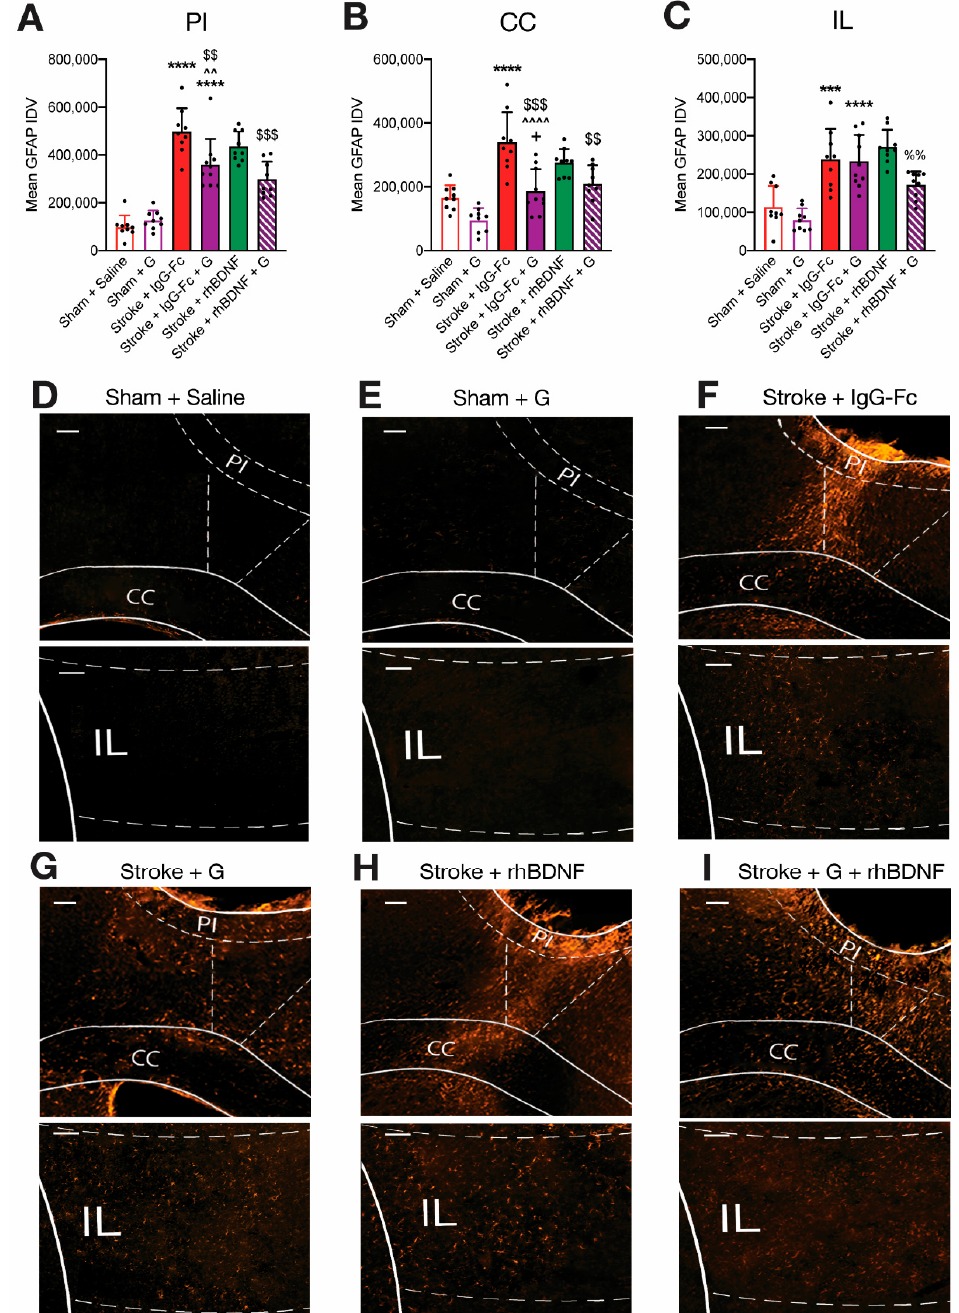
Figure 7. Effects of compound G treatment, with or without rhBDNF, on stroke-induced reactive astrogliosis. PFC strokes induced a significant upregulation in the mean integrated density value (IDV) of GFAP+ve expression in the peri-infarct (PI, ( A )), corpus callosum (CC, ( B )) and infralimbic (IL, ( C )) regions of vehicle-treated animals (sham + saline, n = 9; stroke + IgG-Fc, n = 9). Compound G treatment alone had no effect in sham animals ( n = 9) but significantly dampened stroke-induced elevations in GFAP+ve expression in the PI and CC regions of stroke animals ( n = 9). Moreover, compound G + rhBDNF treatment ( n = 9) further caused a reduction in GFAP+ve expression within IL regions ( D – I ). Two-way ANOVA: *** p < 0.001, **** p < 0.0001, relative to saline-treated sham animals. ^^ p < 0.01, ^^^^ p < 0.0001, relative to vehicle-treated stroke animals; one-way ANOVA: $$ p < 0.01, $$$ p < 0.001, relative to vehicle-treated stroke animals; %% p < 0.01, relative to rhBDNF-treated stroke animals. Scale bar (white bar, top left) = 100 µ